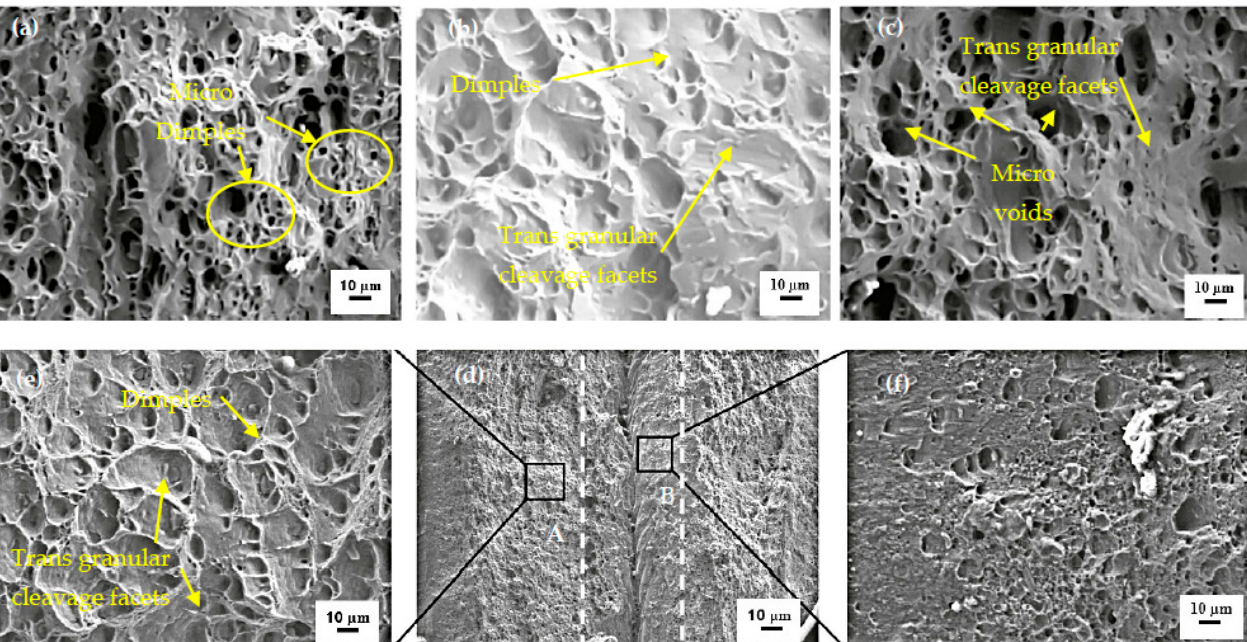
Figure 11. SEM morphology of fractured tensile joints ( a ) NAC ( b ) S-IM ( c ) S-RM ( d ) macro-fractograph of C-RJ ( e ) magnified A zone ( f ) magnified B zone.